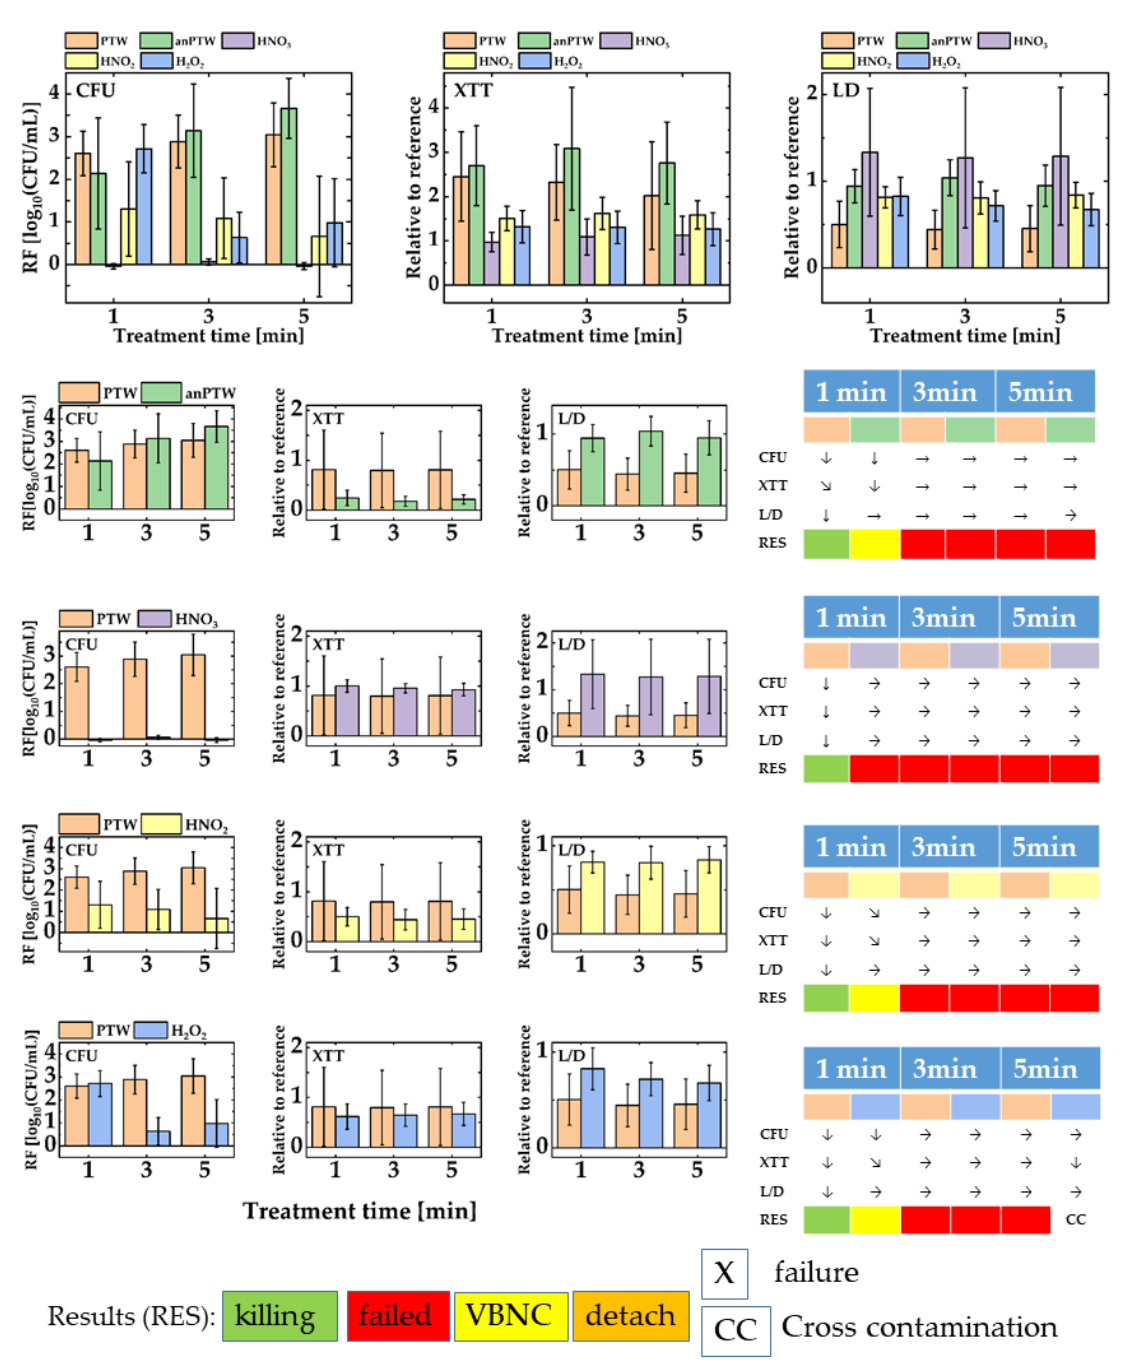
Figure 3. A summary of all assay data (CFU, XTT, and L/D) for suspension cells of Pseudomonas fluorescence. The upper part of the figure gathers all data from all sanitizing solutions (PTW, anPTW, HNO 3 , HNO 2 , and H 2 O 2 ). The lower part of the sketch compares every sanitizing solution versus freshly produced PTW. The result of treatment with such solutions has been underpinned with an assay evaluation system as described earlier (Materials and Methods Section 2.6.2). For convenience, only statistically meaningful changes have been taken into account. In a series of independent ANOVA ( p < 0.5), the results of a certain treatment time have been compared with those of the previous point of the same data set (1 min vs. reference, 3 min vs. 1 min, and so